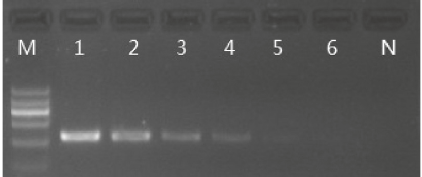
Figure 2: Sensitivity test for pig DNA. Lanes 1–6 represent the PCR products with serial dilution of pig DNA template. The content of pig DNA was 30.0, 10.0, 1.0, 0.1, 0.01, and 0.001ng. Lane N was negative control.